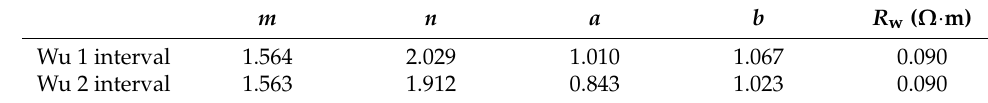
Table 2. Parameters for the Archie equation.